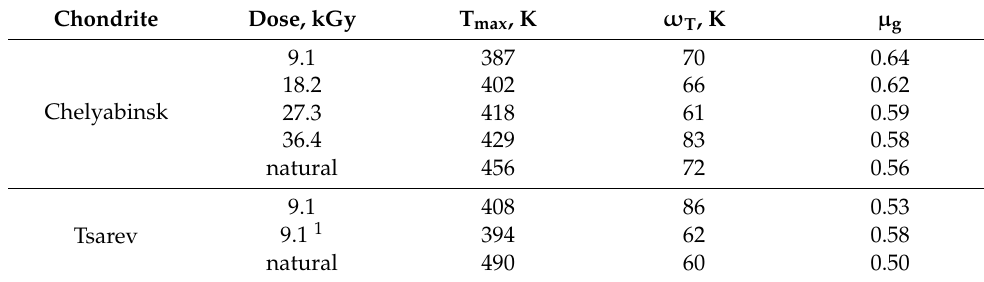
Figure 4. TL glow curves for meteorites irradiated with various doses. ( a ) The Chelyabinsk chondrite: 1—natural, 2—9.1 kGy, 3—18.2 kGy, 4—27.3 kGy, and 5—36.4 kGy. ( b ) The Tsarev chondrite: 6—natural, 7—9.1 kGy, and 8—9.1 kGy after 3 days of storage in the dark. Table 2. TL parameters of chondrites after irradiation.